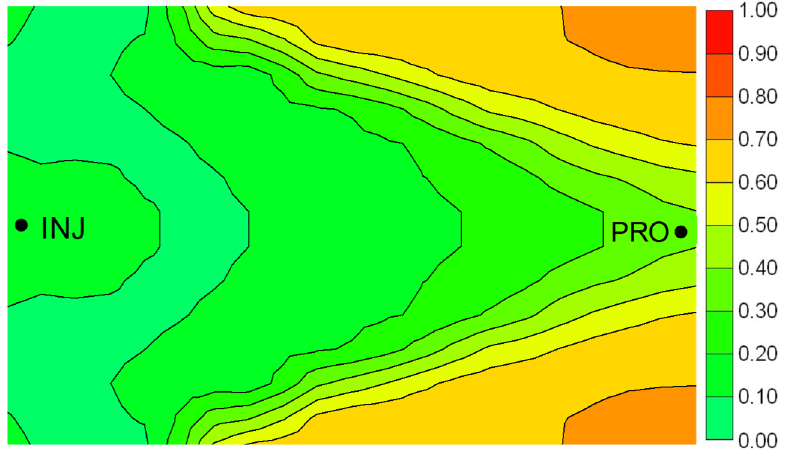
Figure 5. Oil saturation distribution of reservoir after steam flooding.